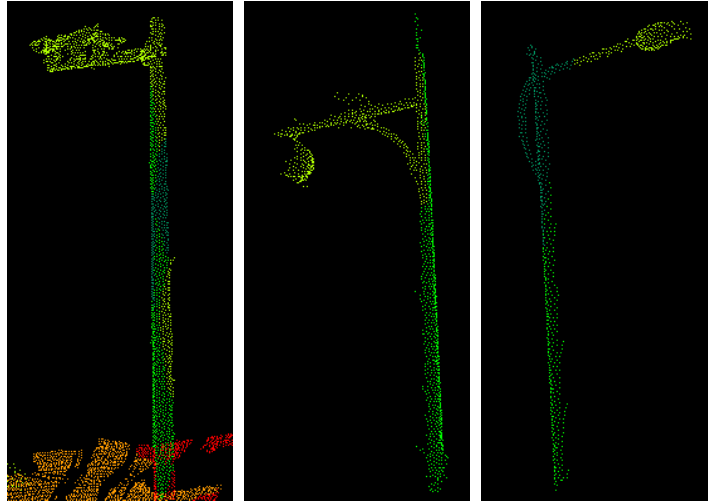
Figure 9. Examples of the misclassification of vegetation with different feature sets: ( a ) Geo, ( b ) Geo